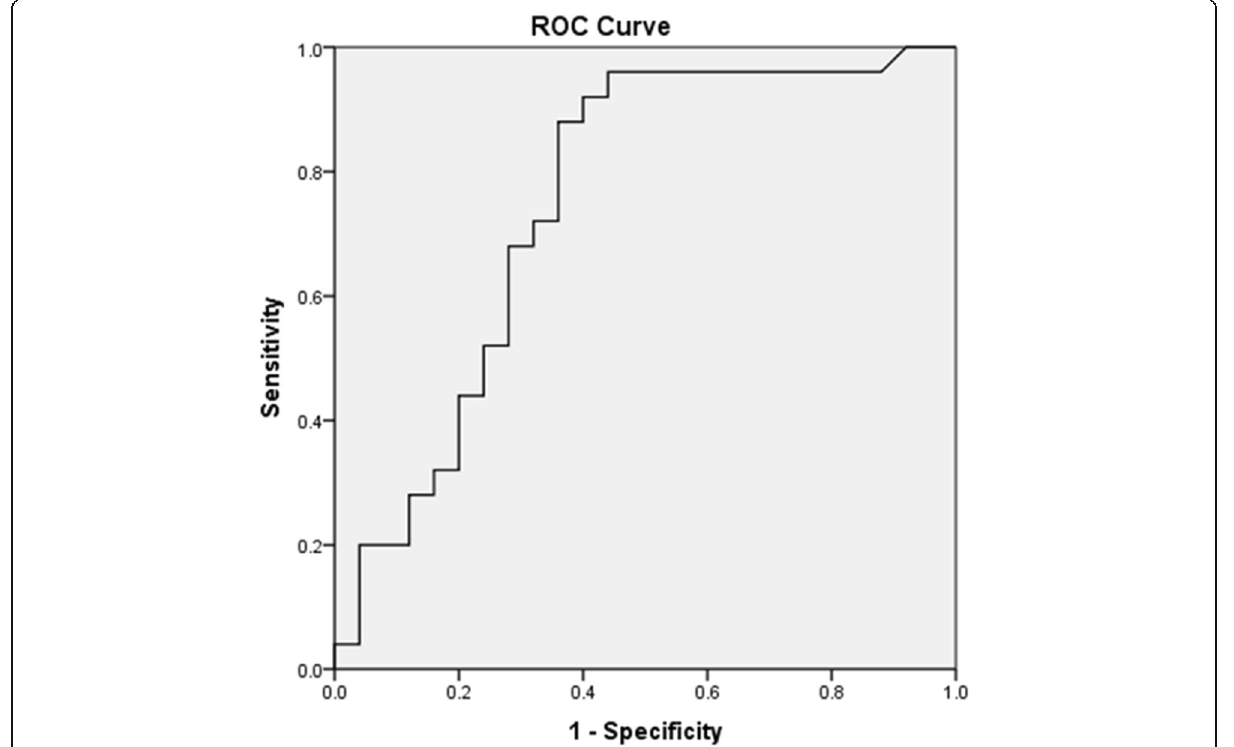
Fig. 1 ROC curve for prediction of poor outcome after acute ischemic stroke using thioredoxin level on admission